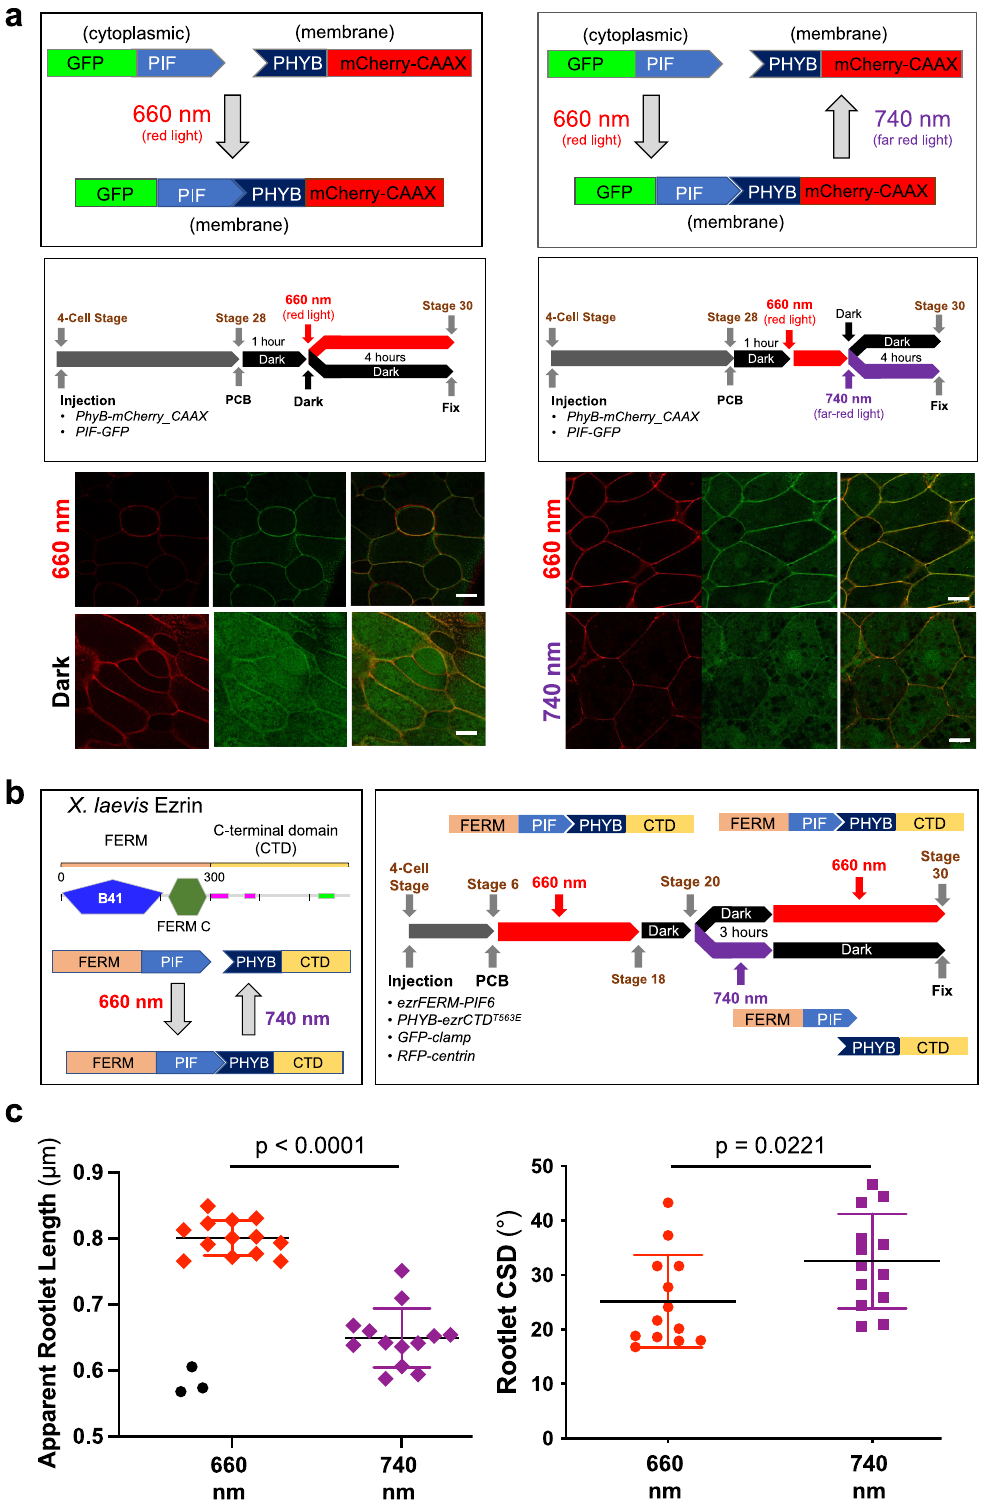
Ezrin fragments interfered with rootlet anchoring. Together, these fi ndings demonstrate that microridges are generated during MCC development through NMII-dependent mechanisms. In mature MCCs, microridges present an essential component of the basal body docking and anchoring process. Microridges are currently a largely neglected organelle 44 . Our fi ndings uncover a hitherto unknown function of microridges, and provide insight into the